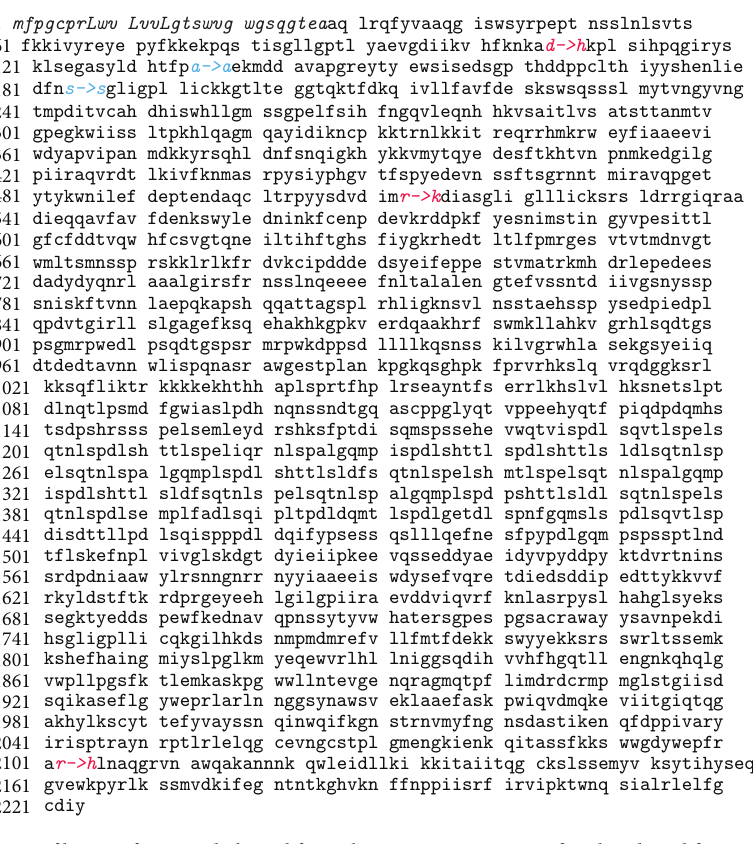
Figure 2: Amino acid sequence of human factor V deducted from the 𝐹5 DNA sequence of proband. Red fonts indicate missense mutations, and blue fonts indicate synonymous mutations. The sequence of first 28 amino acid fragments is given in italics, and the consecutive 25 exons are either underlined or not underlined (pair wise).